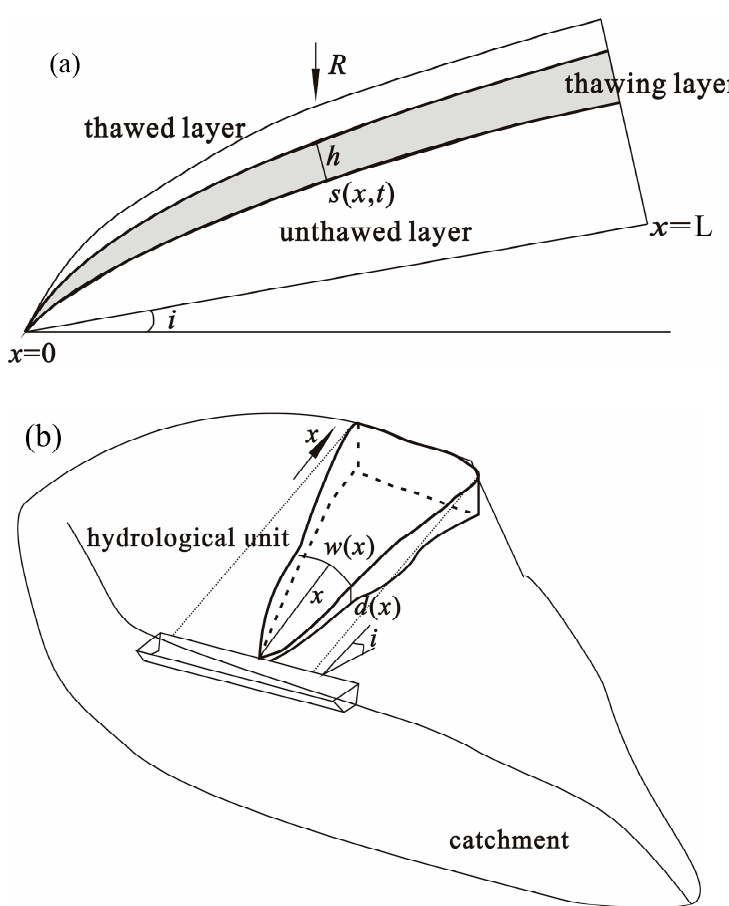
Figure 1. Illustrations of the model used to describe the soil water flow and pollution transport during the thawing period. ( a ) Generalization of the slope structure; ( b ) illustration of the model.